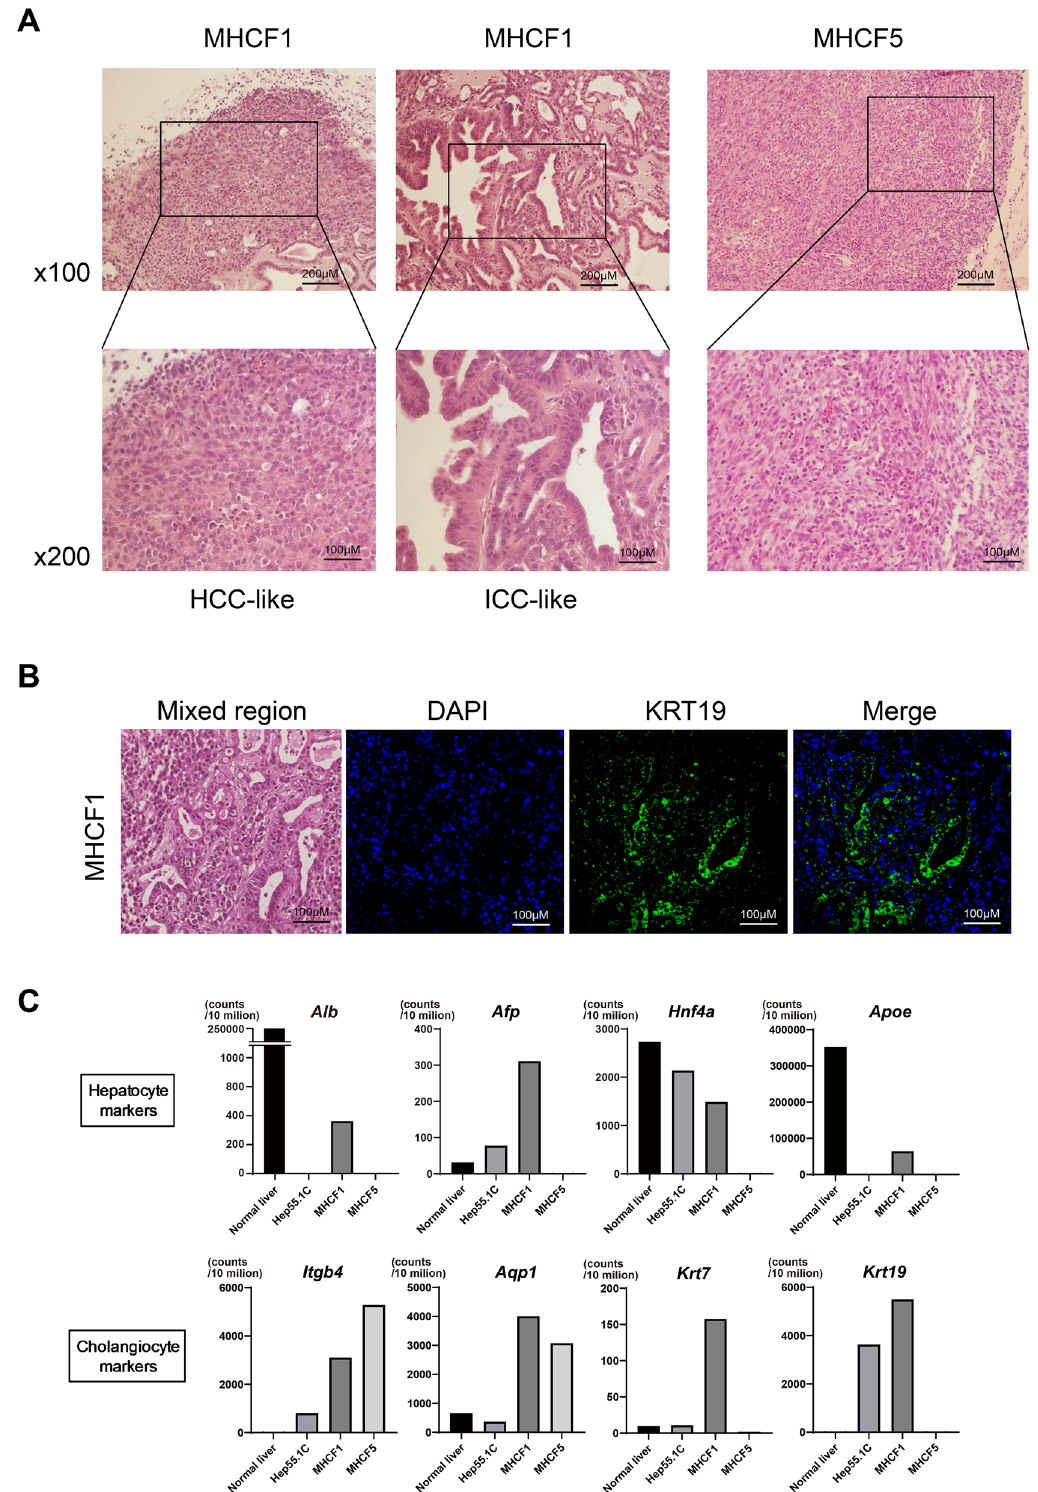
Figure 3. Histological findings and hepatocyte and cholangiocyte markers of the developed MHCF1- and MHCF5-derived tumors. ( A ) Hematoxylin and eosin staining of MHCF1- and MHCF5-derived tumors. ( B ) Mixed lesion of HCC and CCC in an MHCF1-derived tumor and immunofluorescent staining of KRT19. ( C ) RNA-seq results for hepatocyte and cholangiocyte markers in healthy liver, Hep55.1C cells, MHCF1 cells, and MHCF5